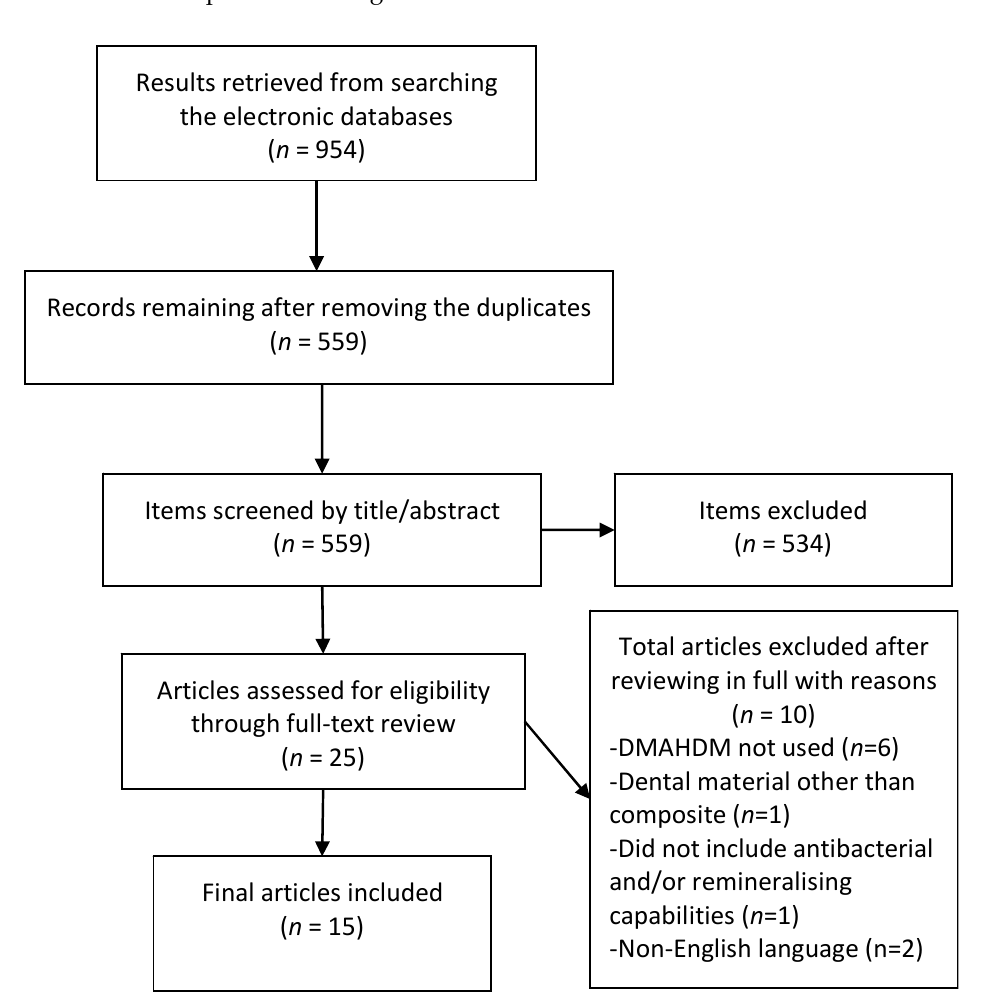
Figure 1. Preferred reporting items for systematic review and meta-analyses (PRISMA) flow chart demonstrating the selection of articles.